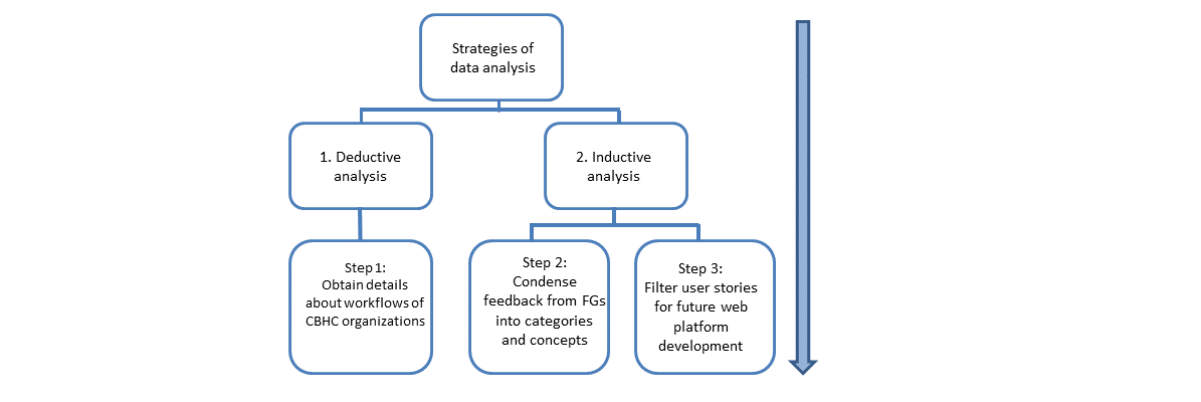
Figure 2. Strategies and steps of focus group data analysis. CBHC: community-based health care; FG: focus